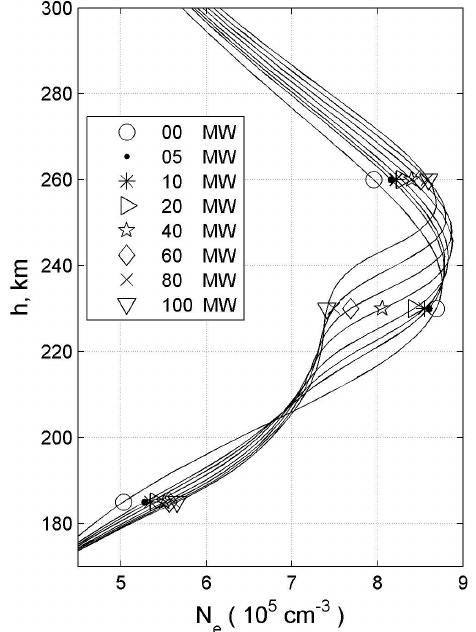
Fig. 6. Profiles of the electron concentration (in units of 10 5 cm − 3 ) versus distance from the Earth along the geomagnetic field line sit- uated in the illuminated region at the moment of 300s after turn on. The results are given for the same cases as in Fig.